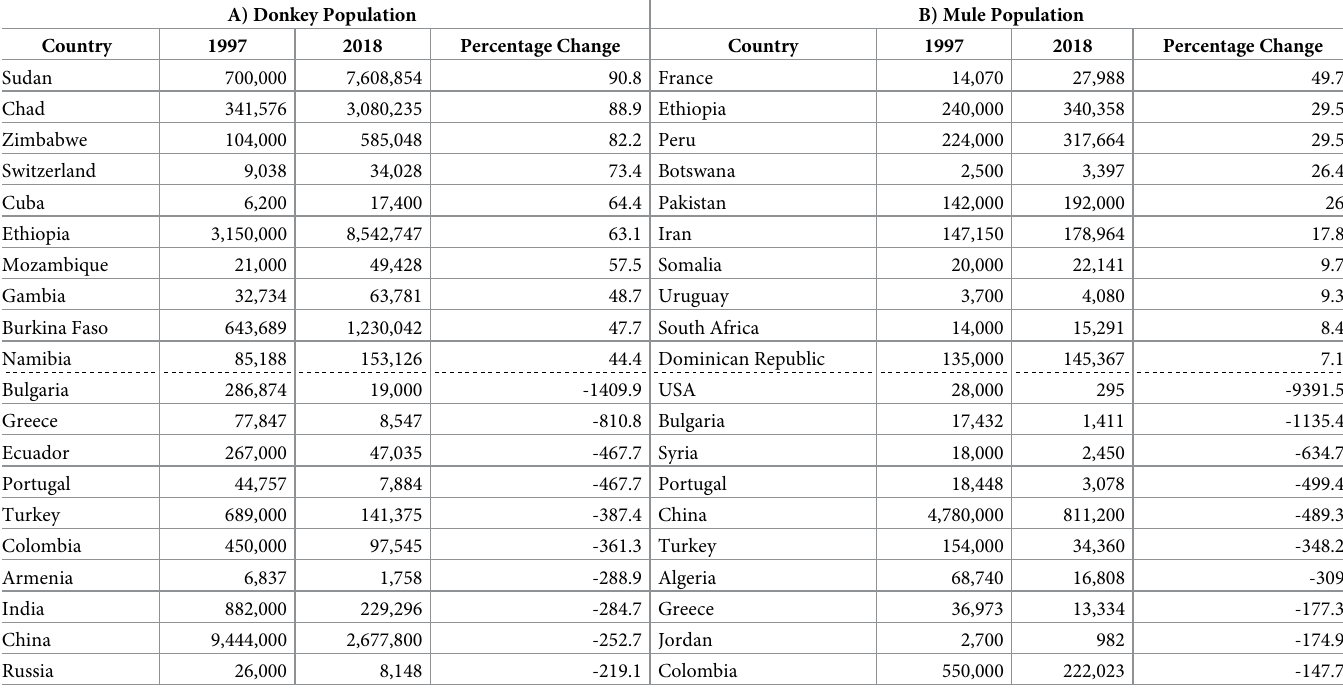
Table 1. Countries with the 10 greatest increases and reductions in donkey (A) and mule (B) population size between 1997 and 2018 where the population in 2017 was greater than